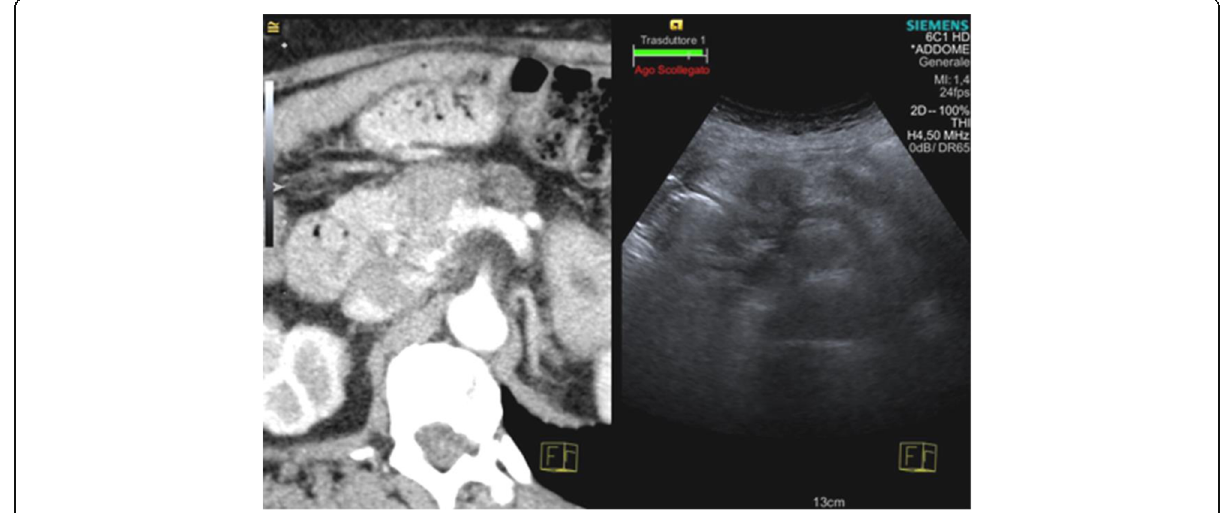
Fig. 3 CT-US fusion imaging. Biopsy of pancreatic neck carcinoma, hypodense on CT and hypoechoic on the US